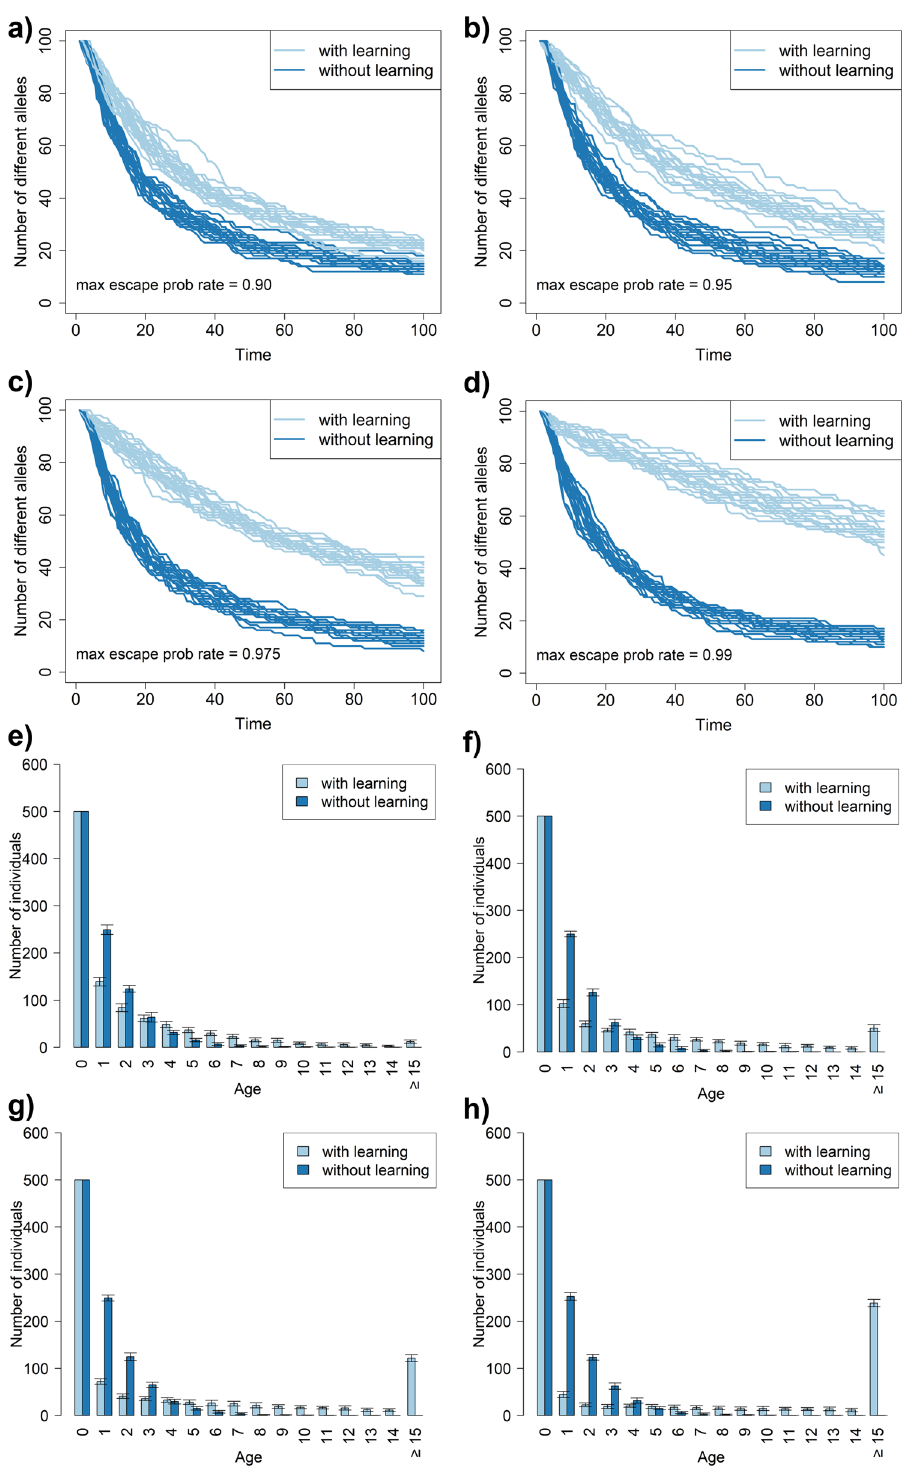
Figure 2. Effectiveness of learning dictates its effect on genetic drift. Temporal dynamics of the number of alleles present in populations of prey subject to predation. Panels ( a – d ) show different settings on the upper bound on the probability of avoiding or escaping predator attack. Panels ( e – h ) show age distributions for panels ( a – d ) (in order). All prey populations consist of 1000 individuals at the beginning of each time step. Individuals killed by predators are replaced at the end of each step through the reproduction of surviving individuals ("Methods"). Predators consume 500 prey individuals per time. Predators kill the same number of individuals in both learning and non-learning scenarios to allow for a fair comparison. Each panel shows 20 simulation runs for both learning and non-learning